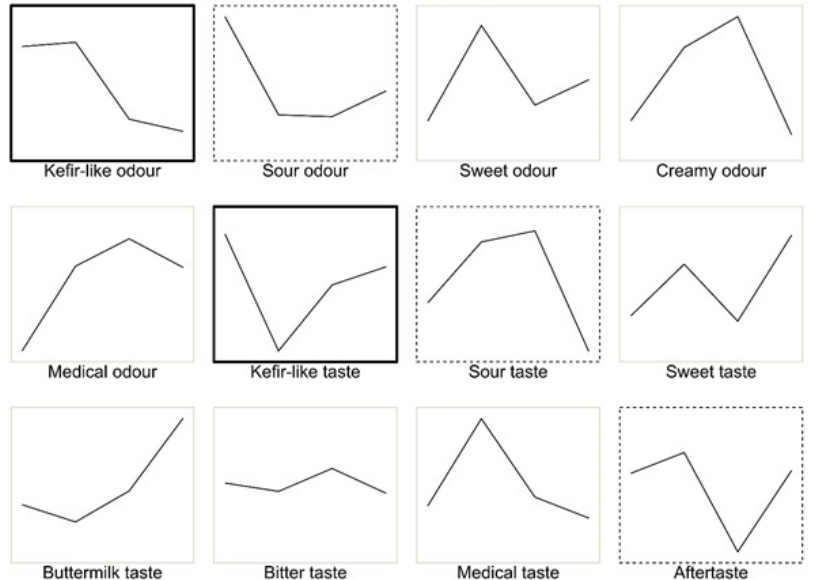
Figure 1. Categorizing the kefir flavor profile of goat’s milk and goat’s milk with permeate after enzymatic conversion of lactose. From left to right: KM—kefir from goat’s milk; KM/GOS—kefir from goat’s milk after enzymatic conversion of lactose; KM + P—kefir from goat’s milk with permeate; KM + P/GOS—kefir from goat’s milk with permeate after enzymatic conversion of lactose.